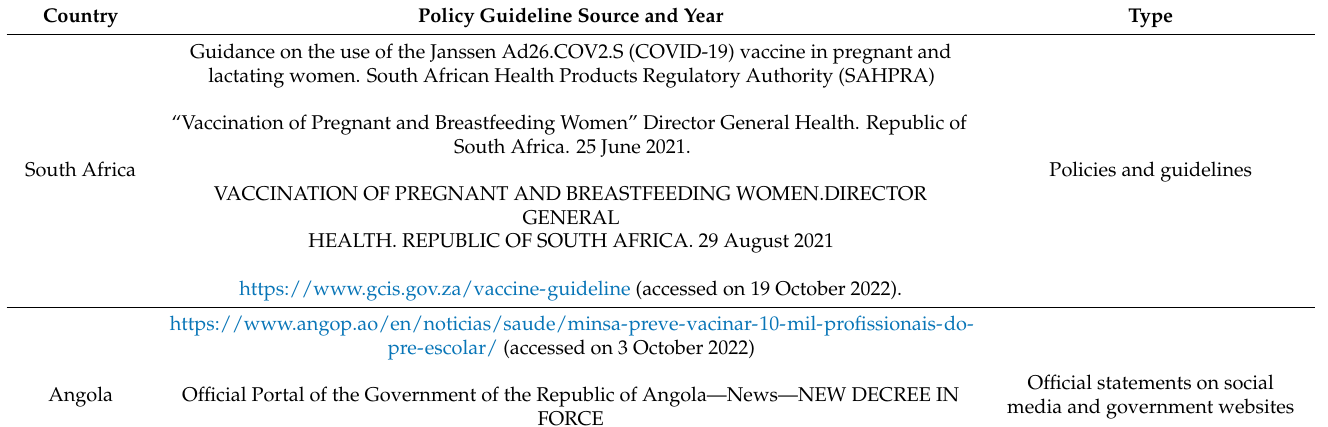
Table 1. COVID-19 vaccination policies and official statements by